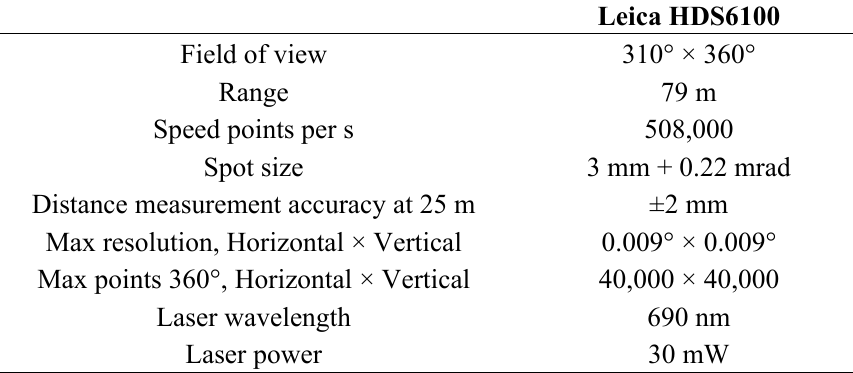
Table 2. Terrestrial laser scanning (TLS) data acquisition